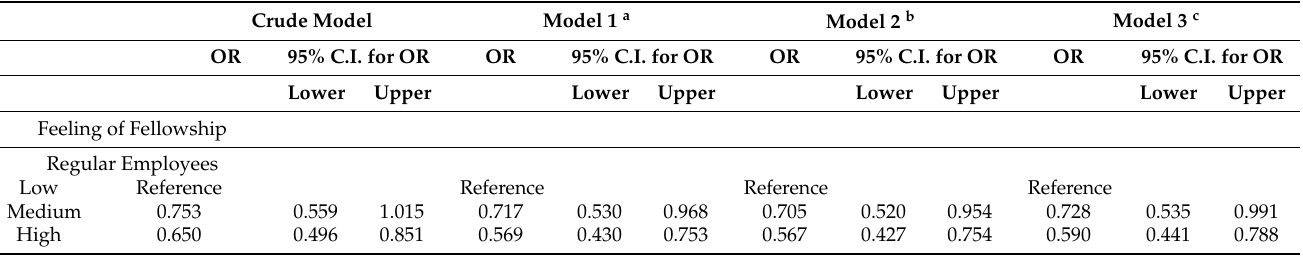
Table 4. Prevalence ratios of each social capital dimension for poor self-rated health